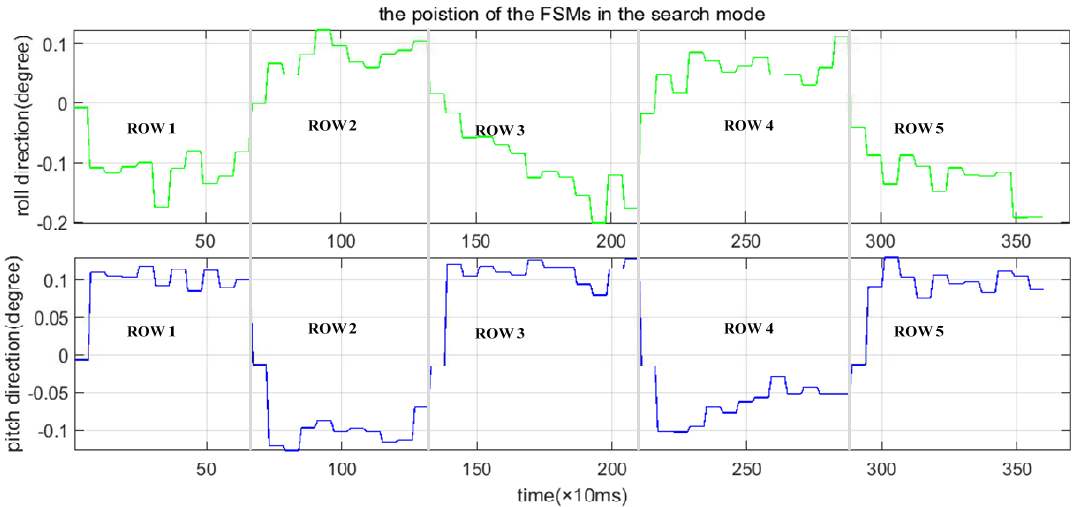
Figure 13. The position of the FSMs in search mode.